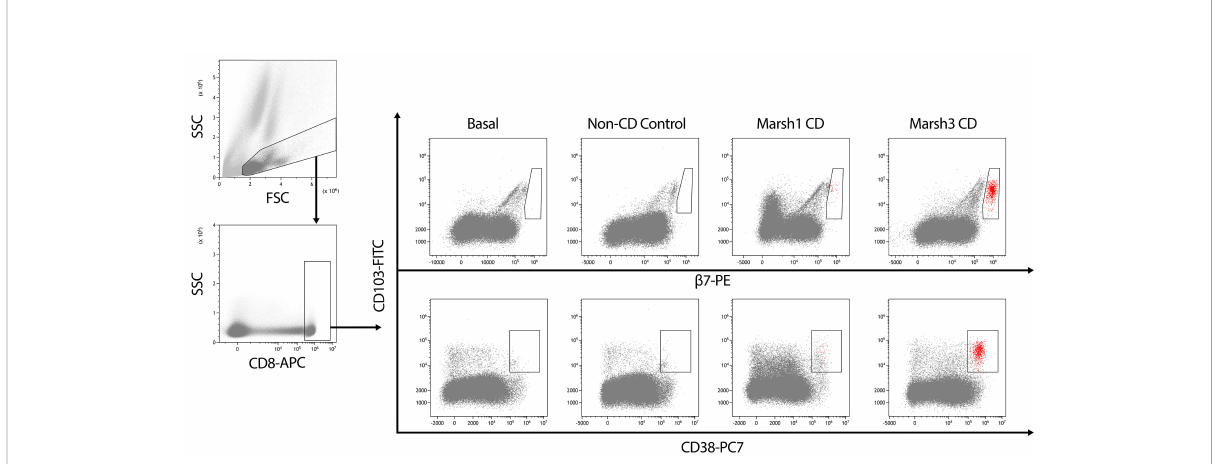
FIGURE 2 Gating strategy to analyze peripheral blood of individuals who underwent a 3-day gluten challenge. FSC vs. SSC gating was used to eliminate debris and select a gate containing the fi rst population of study, which is later used to select CD8 + cells. Then, CD103/ b 7 (upper) and CD103/ CD38 (bottom) dot plots are considered to select the cells being positive for the three respective markers, with the addition that only CD103 + cells with high expression of b 7 are considered and shown in red in the CD103/CD38 plot. The blood lymphogram allows for the identi fi cation of different patterns in celiac disease (CD) and non-CD individuals. In CD, a higher response is observed in individuals with atrophy (Marsh 3) at onset. A total of 80,000 CD8 T cells is displayed in all the